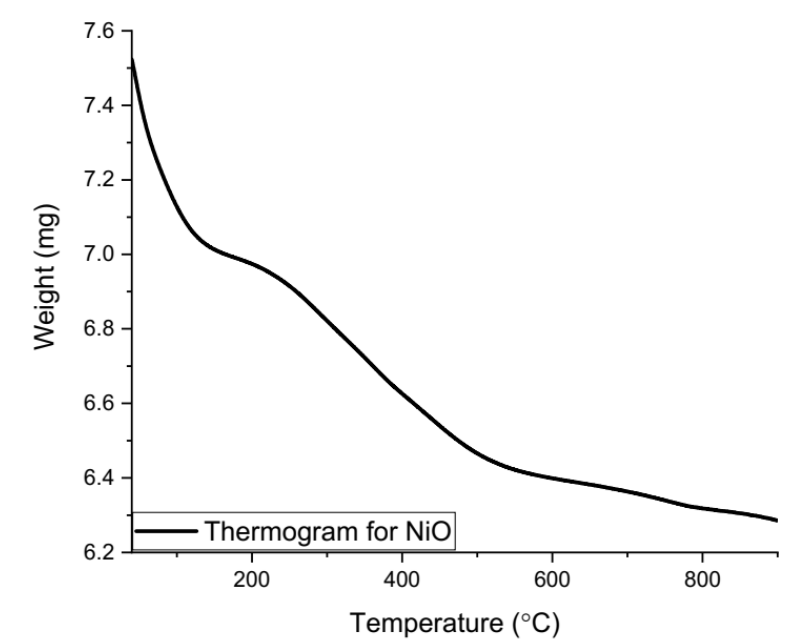
Figure 8. TGA graph of green synthesized NiO